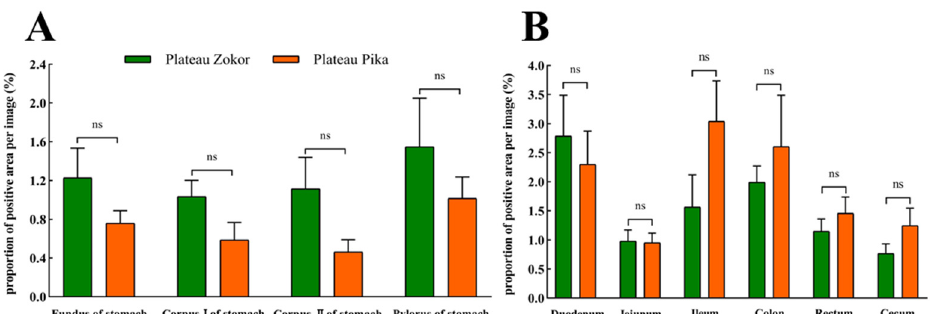
Figure 8. The difference in positive expression levels for Gas-immunoreactive cells in the gastroin- testinal organs of the plateau zokor and plateau pika. ( A ) In the stomach; ( B ) in the intestinal tract. ns indicates an insignificant interspecific difference.